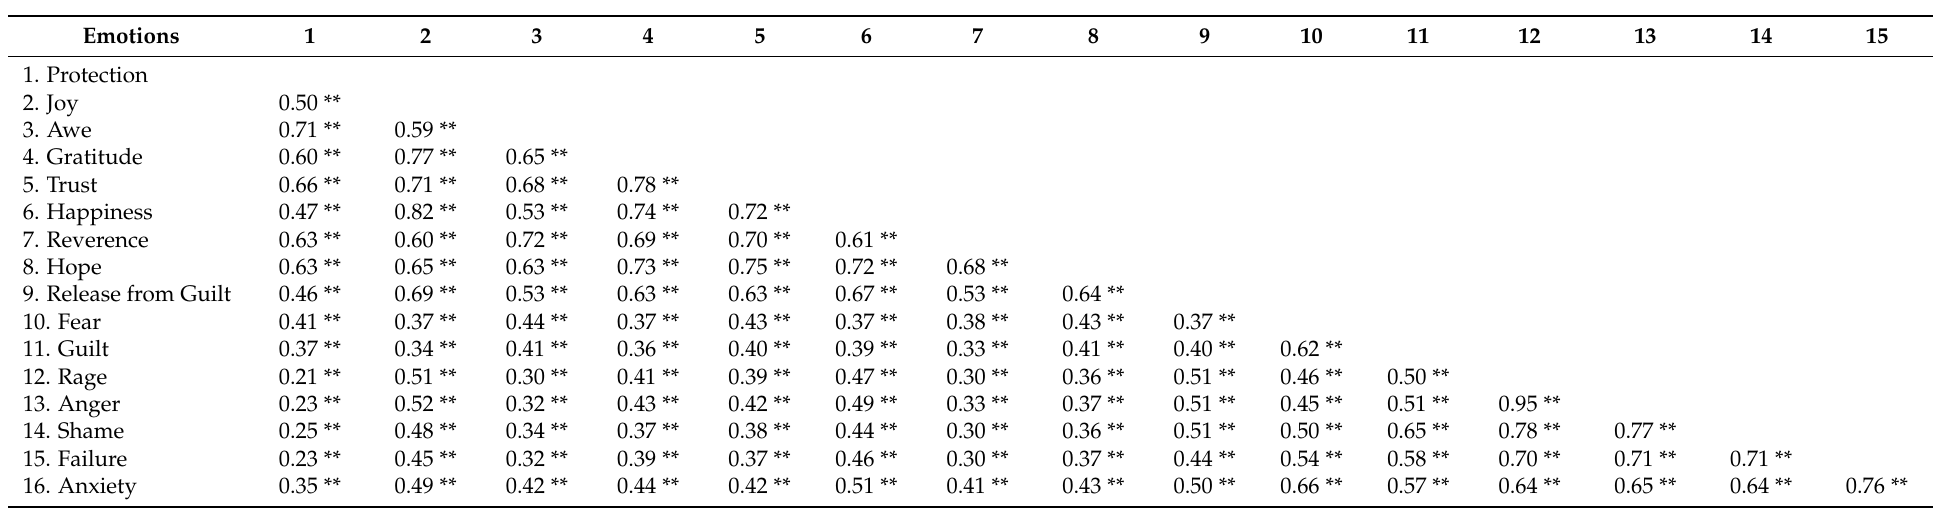
Table 2. Correlation matrix of the EtG